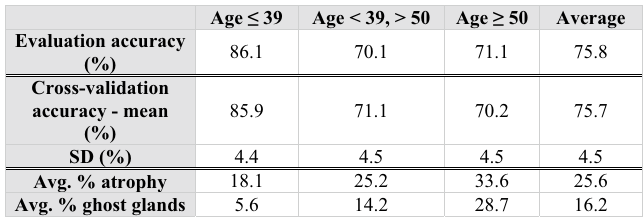
Table 4. Age prediction results. The model predicts the subject age with an average accuracy of 77%, and the two most important morphological features are percent area of gland atrophy and percentage of ghost glands. First 4 rows: classification accuracy for subject age prediction of the demographic feature prediction model. The second row reports accuracies on the evaluation set and the last two rows report means and standard deviations of accuracies on the five-fold cross-validation set. Last two rows: Average values for the top 2 most highly weighted (largest model coefficients) morphological features stratified on age